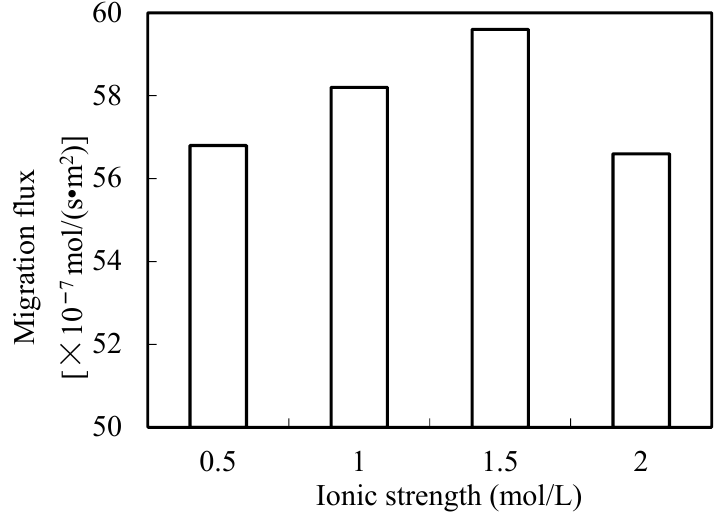
Figure 12. Effect of ionic strengths on the migration of praseodymium (III).